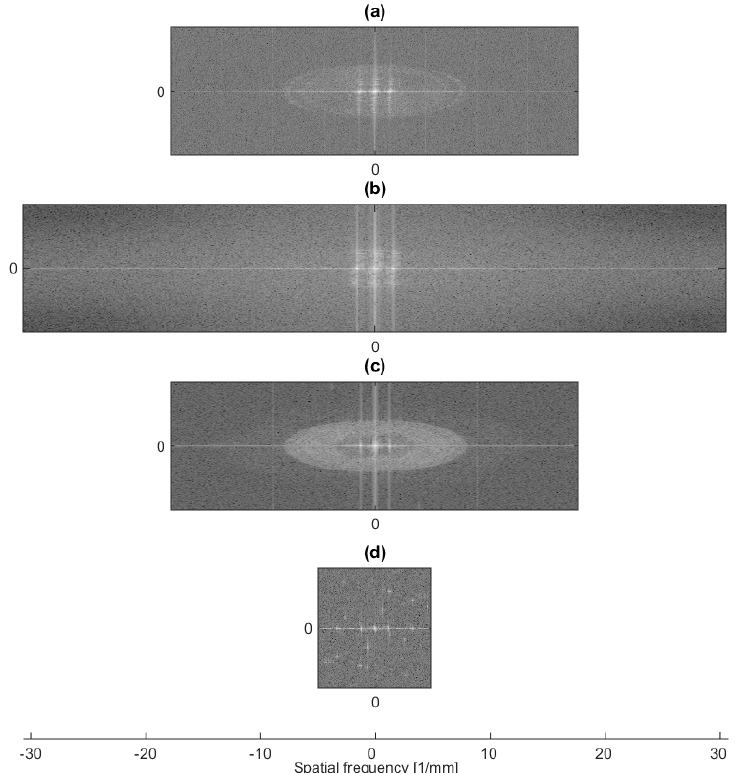
Figure 7. Fourier transform of the interference pattern recorded at λ = 118.8 μ m. ( a ) Cam1; ( b ) Cam2; ( c ) Cam3; ( d ) Cam4.